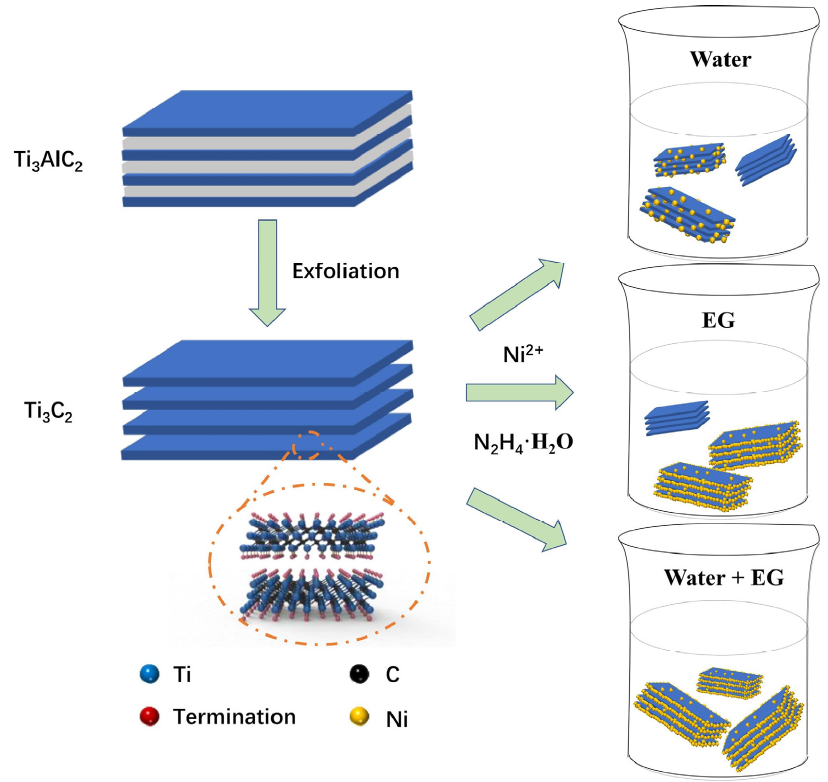
Figure 12. The synthesis procedures of sandwich-like Ni/Ti 3 C 2 catalysts. Copyright 2021, Elsevier. Reproduced with permission from [106].